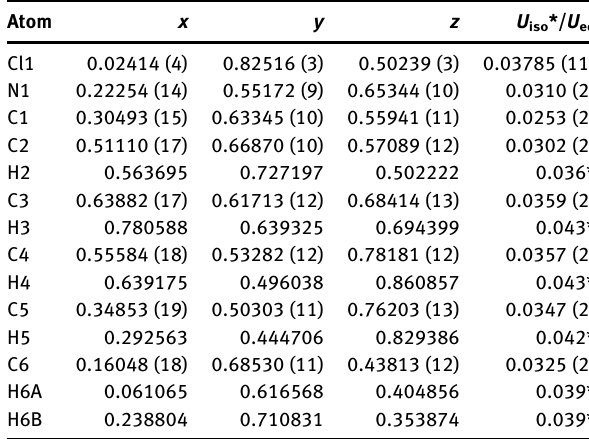
Table  : Fractional atomic coordinates and isotropic or equivalent isotropic displacement parameters (Å 